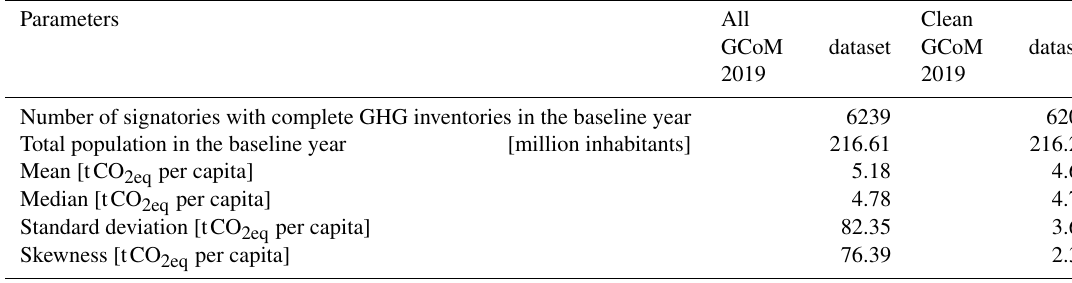
Table 3. Statistical parameters of the GHG emissions in the 2019 GCoM datasets.